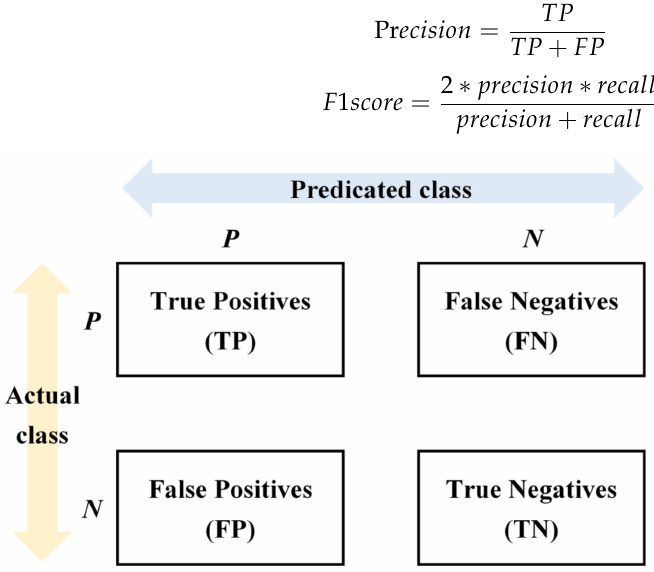
Figure 4. Truth Table Confusion